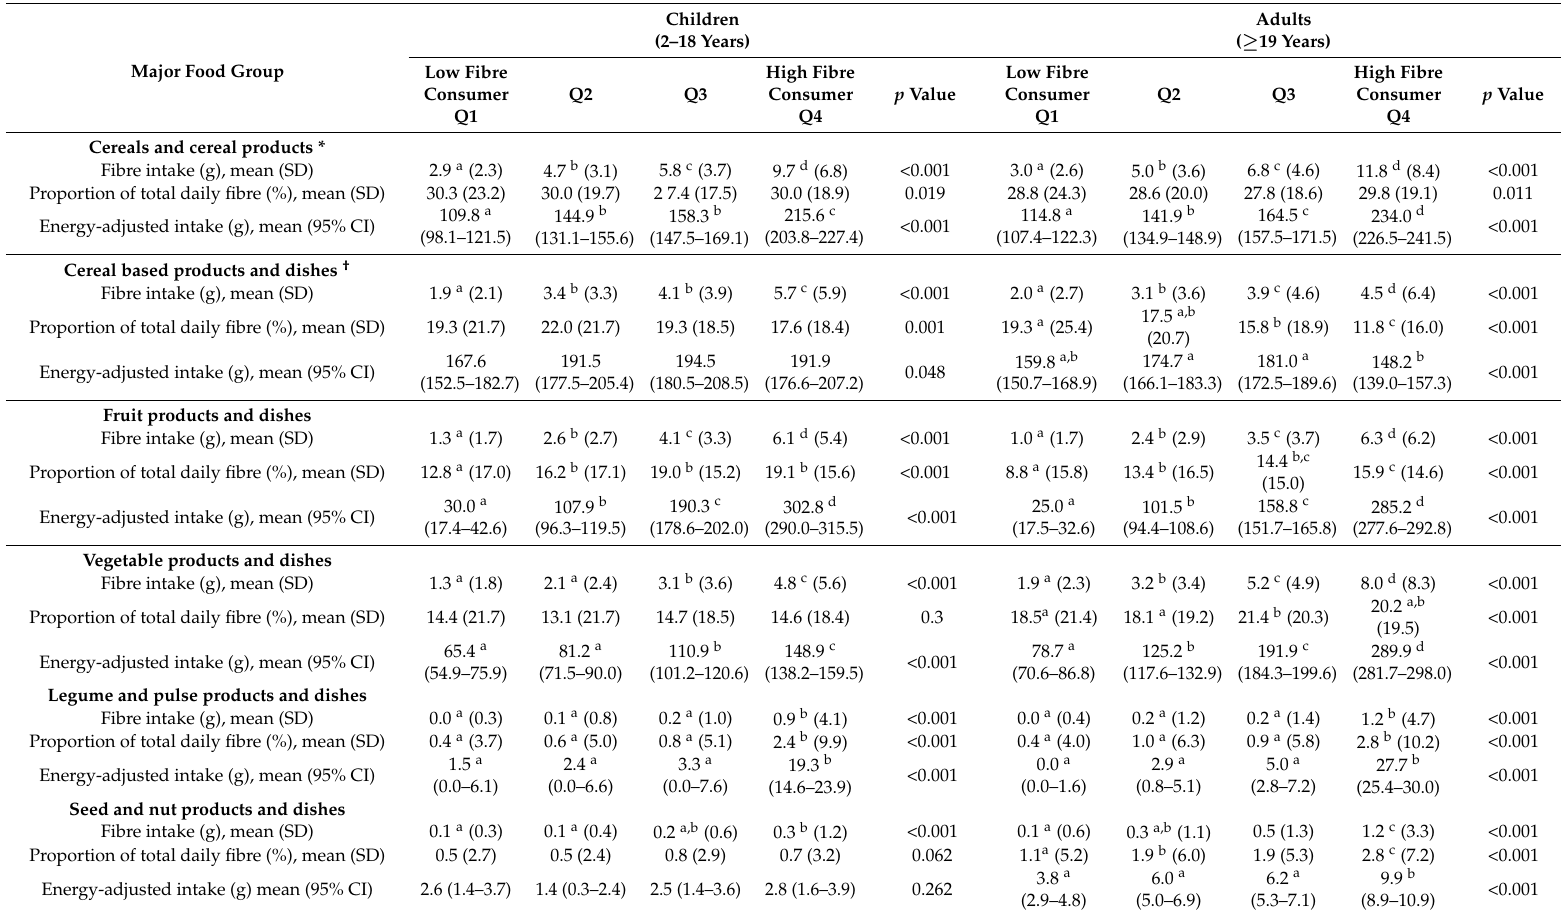
Abbreviations: Q, quartile; SD, standard deviation; CI, confidence interval. Different superscripts a, b, c, d denote significant difference between groups ( p < 0.001). * Includes flours and other grains, breads, pasta and pasta products (without sauce), and breakfast cereals. † Includes sweet and savory biscuits, cakes, muffins, and desserts, pastries, cereal mixed dishes, and batter-based